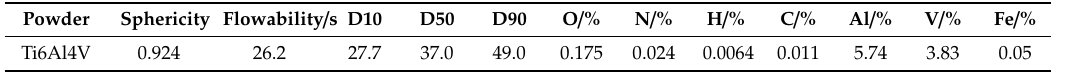
Table 2. The relevant processing information about the Farsoon FS271M.